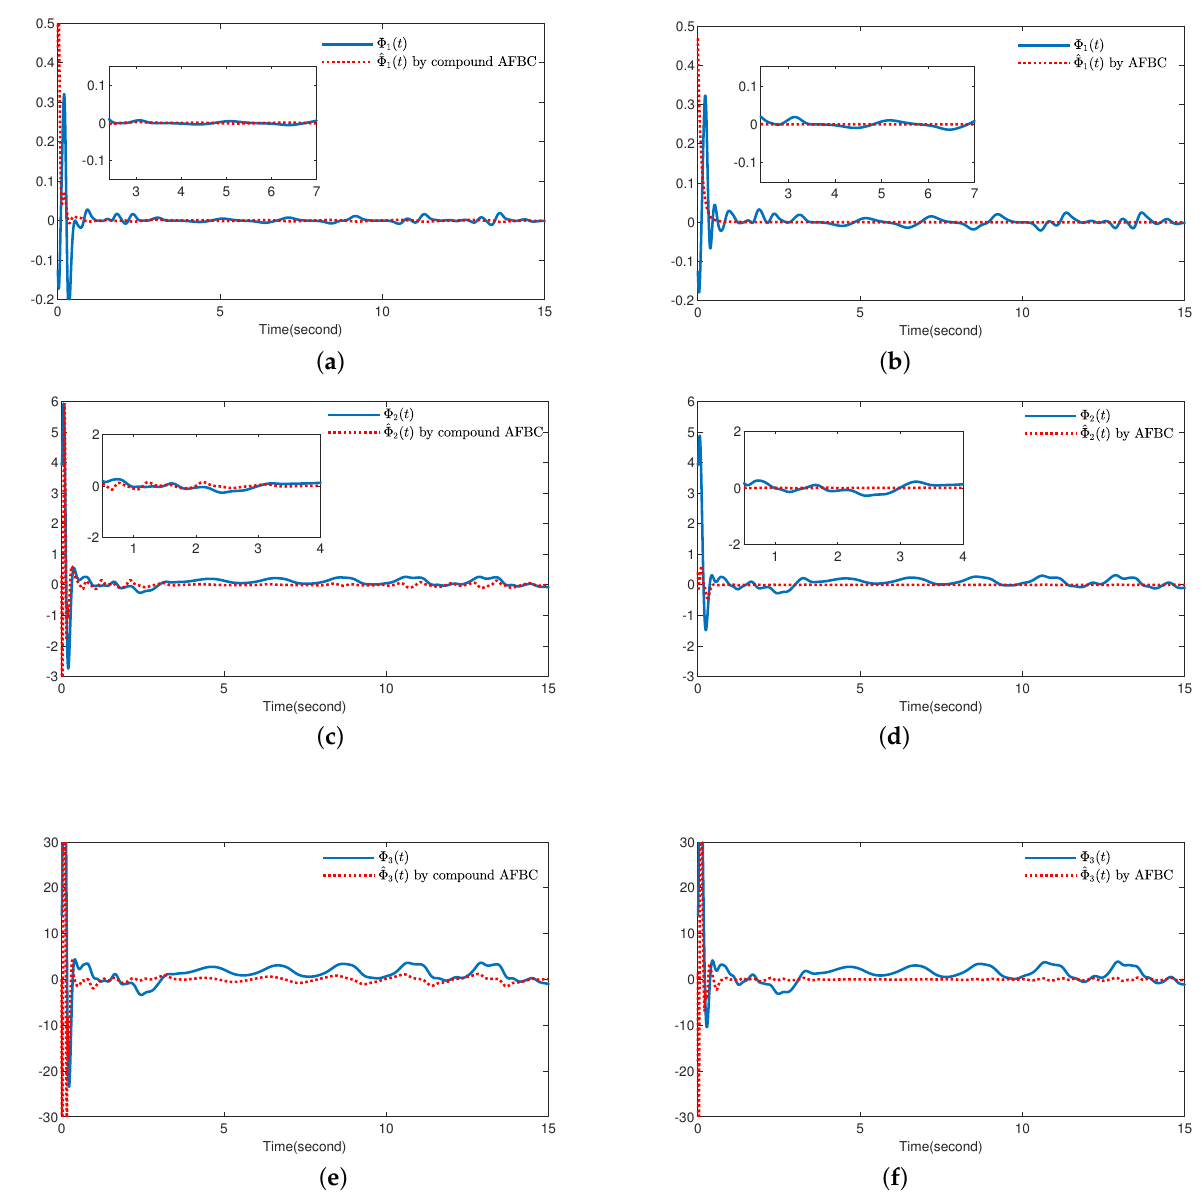
Figure 2. Comparison results: ( a ) the approximation effect of Φ 1 by utilizing the compound AFBC; ( b ) the approximation effect of Φ 1 by utilizing the AFBC; ( c ) the approximation effect of Φ 2 by utilizing the compound AFBC; ( d ) the approximation effect of Φ 2 by utilizing the AFBC; ( e ) the approximation effect of Φ 3 by utilizing the compound AFBC; ( f ) the approximation effect of Φ 3 by utilizing the